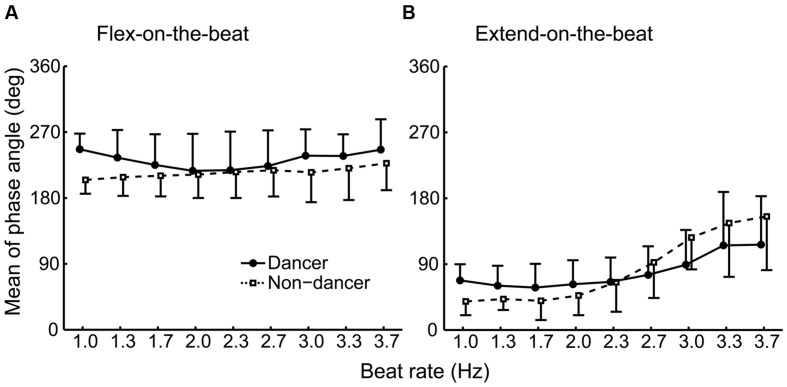
Group average of the mean phase angle under the flex-on-the-beat (A) and the extend-on-the-beat (B) conditions. The dashed line denotes the non-dancers, and the solid line denotes the dancers. The vertical bars represent the between-subject standard deviations (SDs). The data of dancers include the world champion.